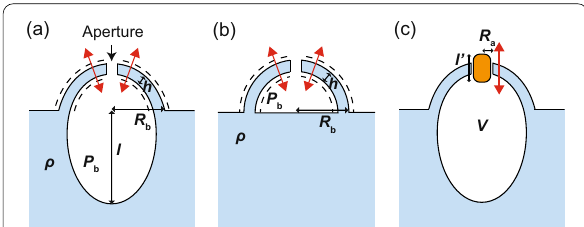
Fig. 3 Schematic diagrams showing several mechanisms of airwave excitation. a Film vibration of a bubble with a hemispherical cap and a hemispheroid below the surface. b Film vibration of a hemispherical cap bubble. c Helmholtz resonance at the neck (effective length l ′ )